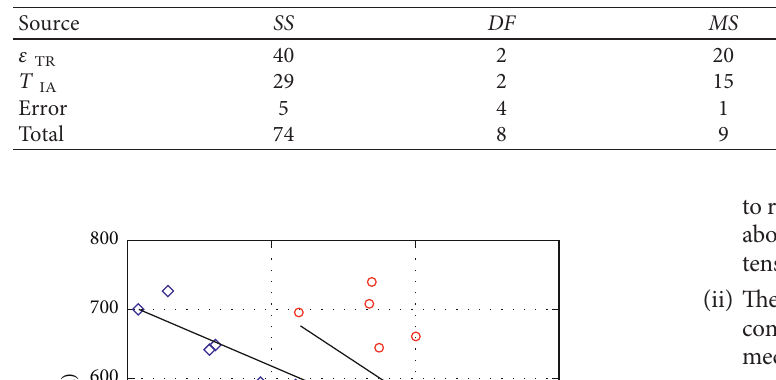
Table 6: ANOVA for